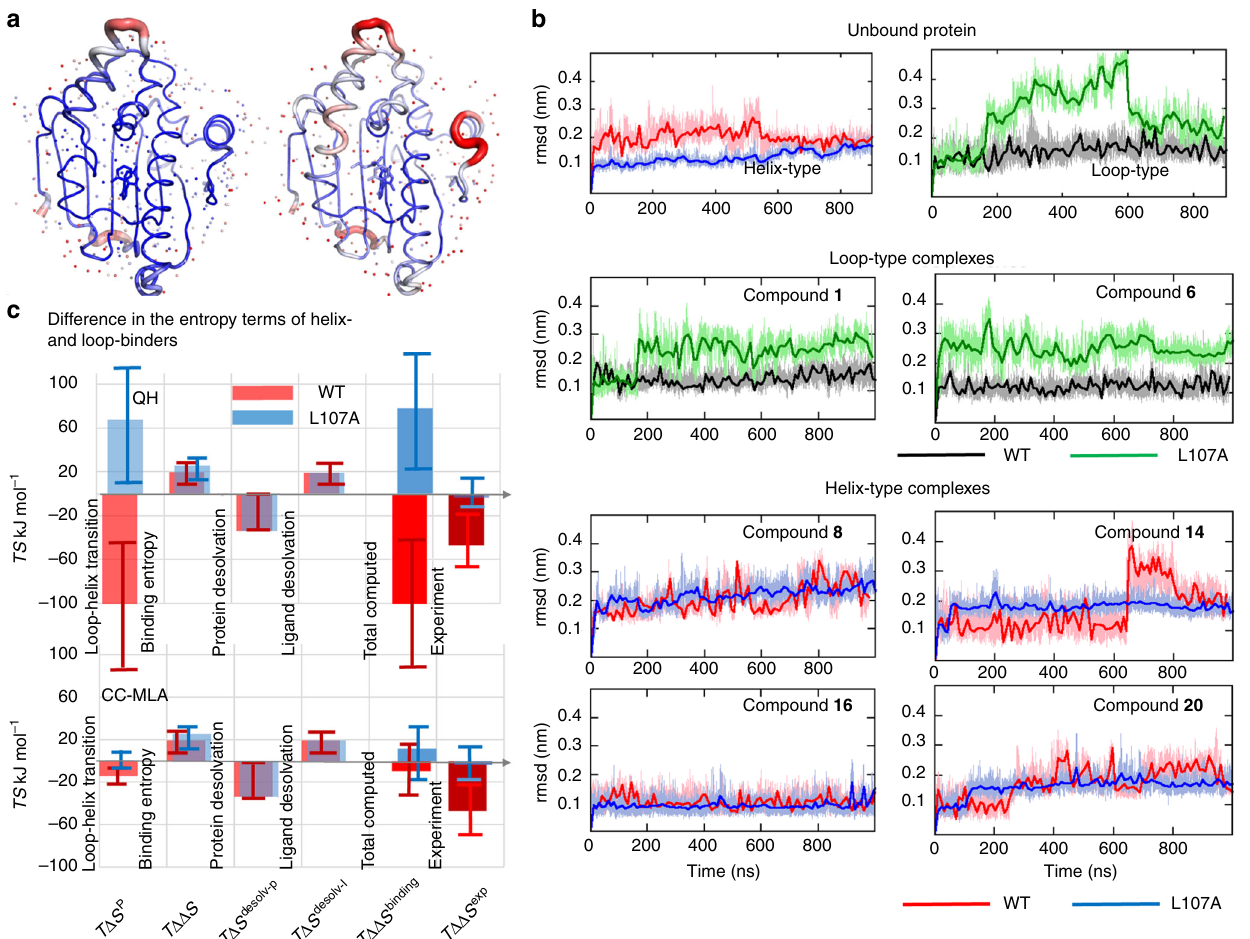
Fig. 5 Simulations of the fl exibility of WT-N-HSP90 and the L107A mutant. a Crystal structures of the loop-in (left) and helical (right) conformations with typical crystallographic B-factor values shown by cartoon ribbon radius and color, increasing from blue to red. b Variations of the RMSD of α -helix3 (residues 96 – 126) along 1 μ s MD trajectories in loop-in and helical conformations of several complexes; the bold curves represent cubic splines of the original (gray, light-red, light-green, or light-blue) curves (the corresponding RMSF variations are shown in Supplementary Fig. 6). c Difference in the binding entropy of the helix - with respect to the loop-binders (averaged over complexes with compounds 8 , 14 , 16 , 20 , and 1 , 6 , respectively) as observed in experiments ( T ΔΔ S EXP ) and in computations ( T ΔΔ S binding ) from the sum of the conformational entropy of the α -helix1 and α -helix3 segments ( T Δ S l-h P obtained using QH and CC-MLA approaches; see Methods section and Supplementary Figs. 7, 8b, and 9e); the binding entropy arising from the ligand and protein motion, but assuming that the protein has the same conformation in apo- and holo-states ( T ΔΔ S , Supplementary Fig. 8b); the ligand desolvation energy ( T ΔΔ S desolv-l , Fig. 4a), and the protein desolvation energy obtained from the analysis of water sites around the fl exible region of the α -helix3 in crystal structures ( T ΔΔ S desolv-p ). Error bars indicate the standard deviations within an ensemble of